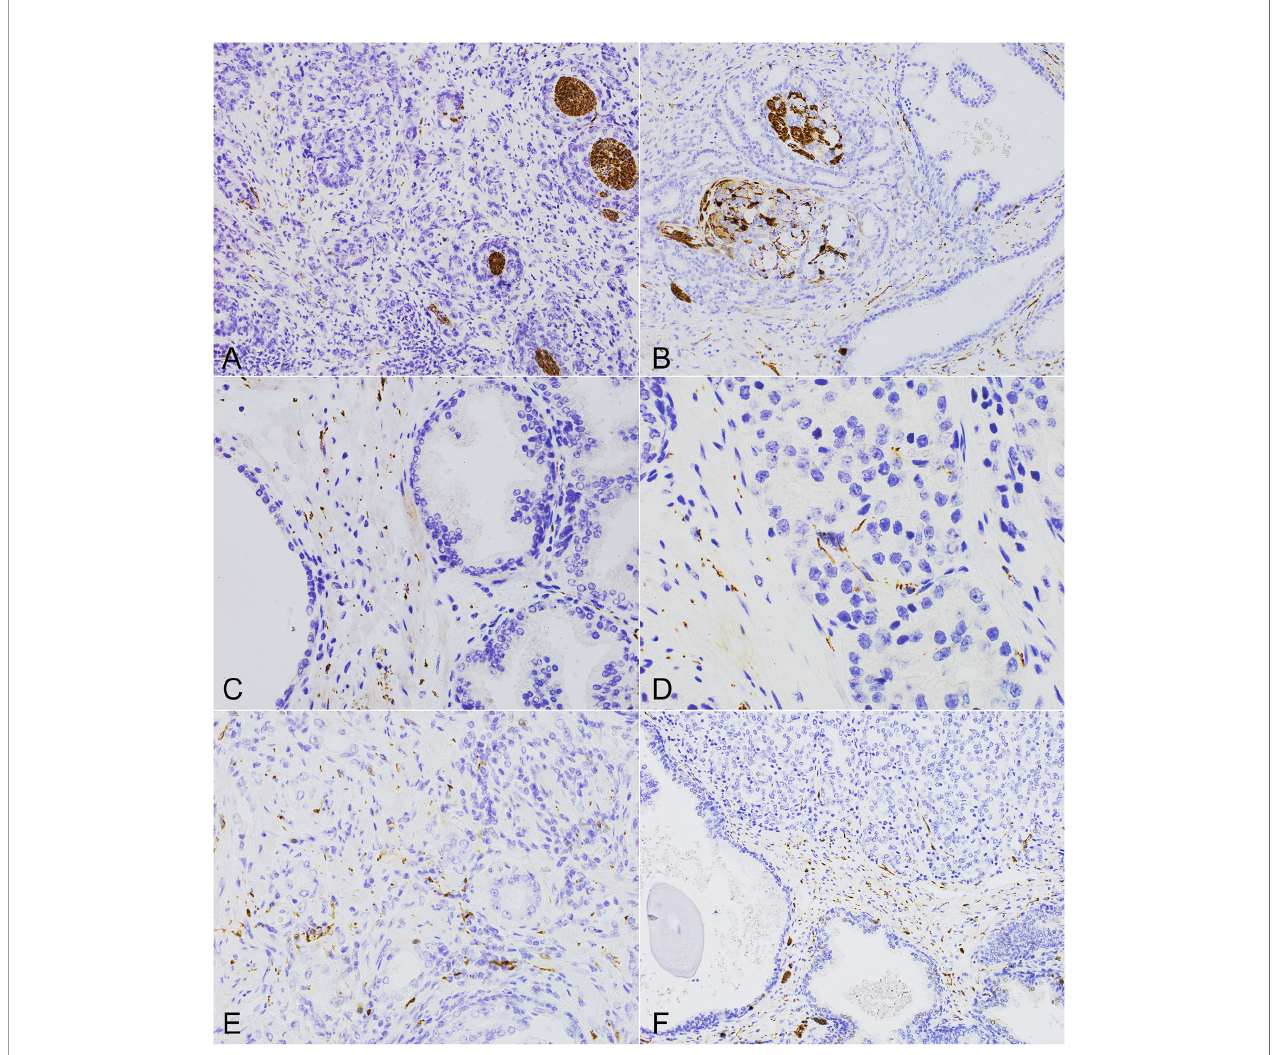
FIGURE 1 | The morphology of perineural invasion and axonogenesis in PCa and the benign prostate. (A, B) Different forms of perineural invasion and small nerves within the cancerous in fi ltration (PGP 9.5, 200x). (C) Multiple axons and small nerves within the stroma of the benign prostate (PGP 9.5, 400x). (D, E) Axons within the neoplastic in fi ltrate located in the stroma and surrounding cancer cells ( D , TH, 600x), ( E , TH, 400x). (F) High neural density in the surrounding benign prostate with axons growing into the cancer tissue of high Gleason score PCa (PGP 9.5,